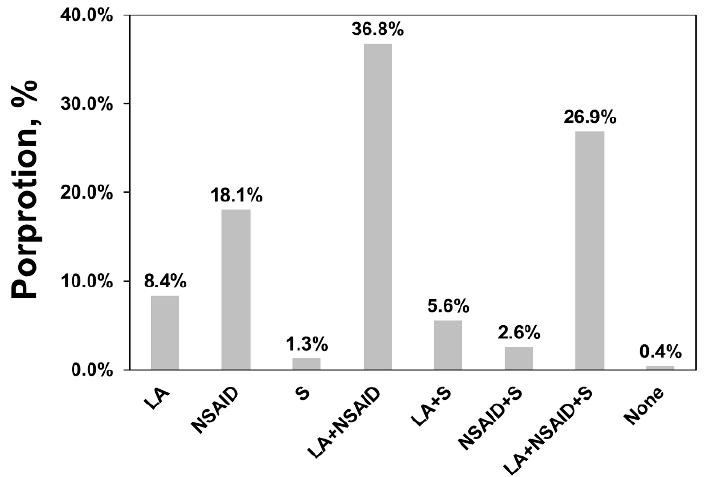
and farms with ≤ 500 cattle were treated as the reference for gender, age, education level, position, and farm scale, respectively.